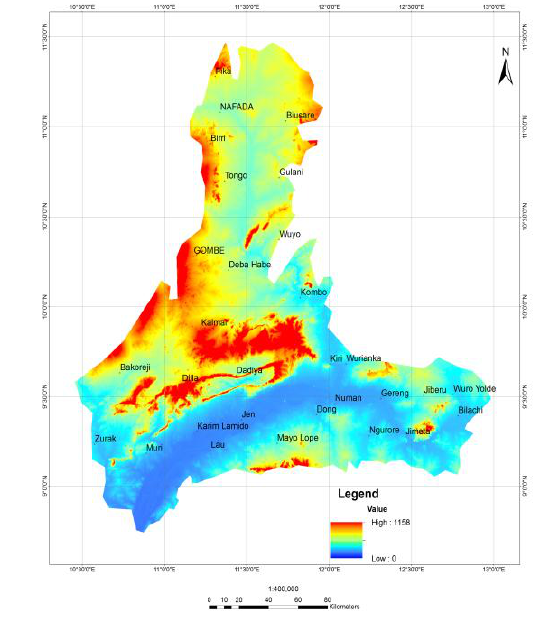
Figure 6. Digital Elevation Model (DEM) of the Upper Benue